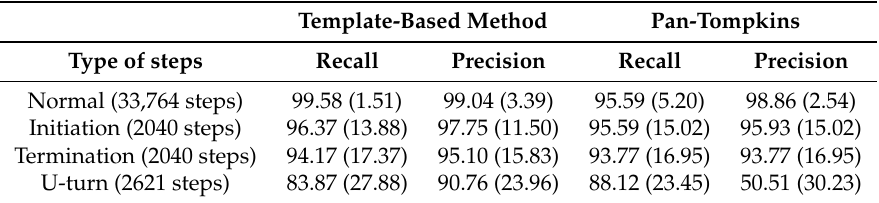
Table 3. Precision and recall scores for the template-based method and the Pan-Tompkins method for different types of steps. Means and standard deviations are displayed.